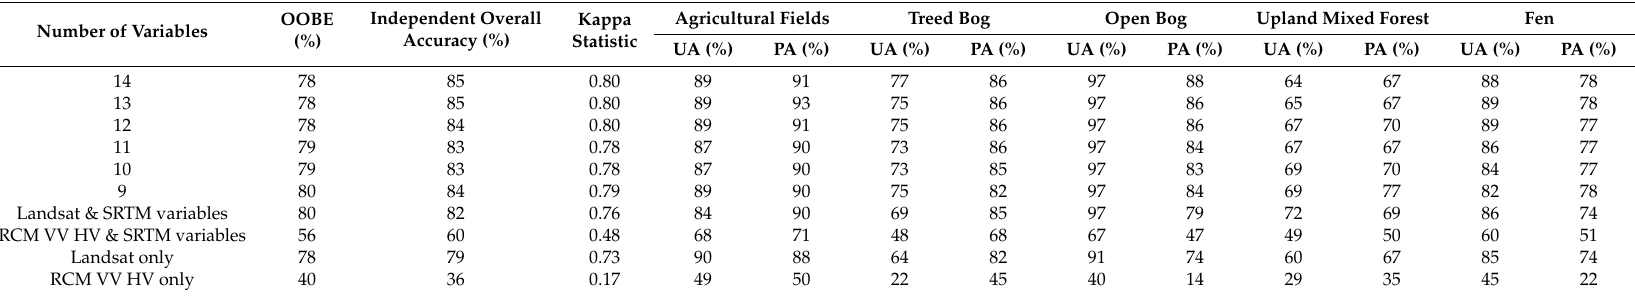
Table A6. Statistical results from the RCM Dual Pol VV+VH NESZ − 19 dB (2 May 2014), Landsat-8 (24 April 2014), and SRTM variables spring model. The first iteration was run with all 14 variables, and variables ranked to be unimportant were then removed until 9 variables remained. The final variables in the model with the highest independent overall accuracy (14 variables) in order of decreasing importance were the seven Landsat-8 bands, VV Intensity, HV Intensity, Total Power, VV/HV ratio, SRTM DEM, SRTM slope, and SRTM aspect.